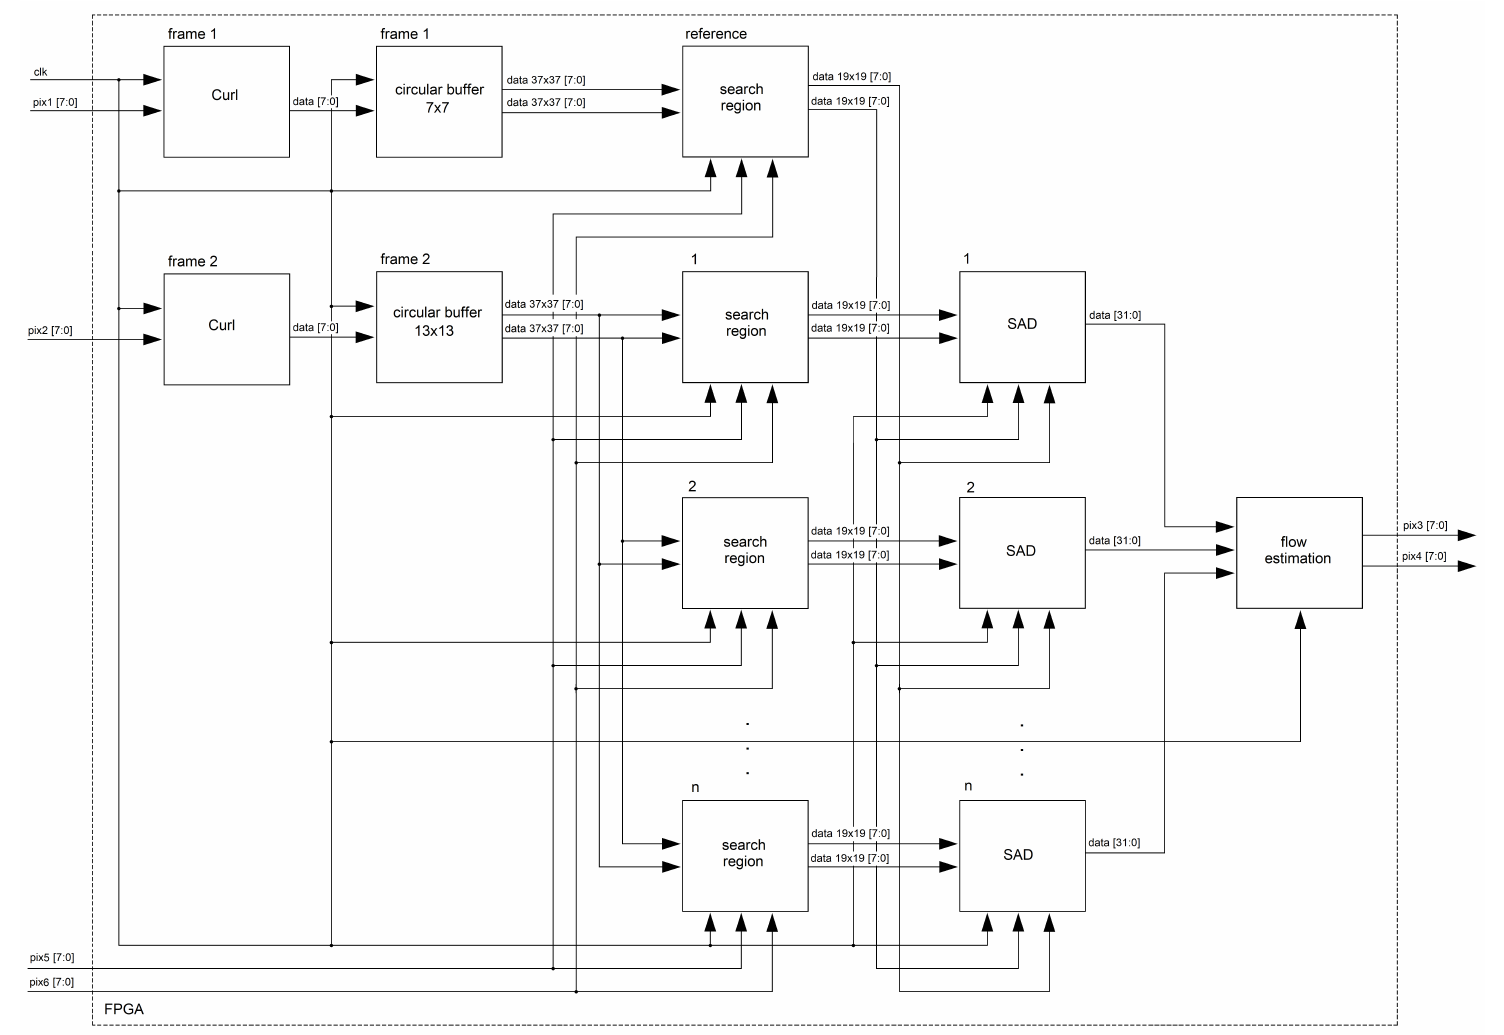
Figure 10. FPGA architecture for the optical flow